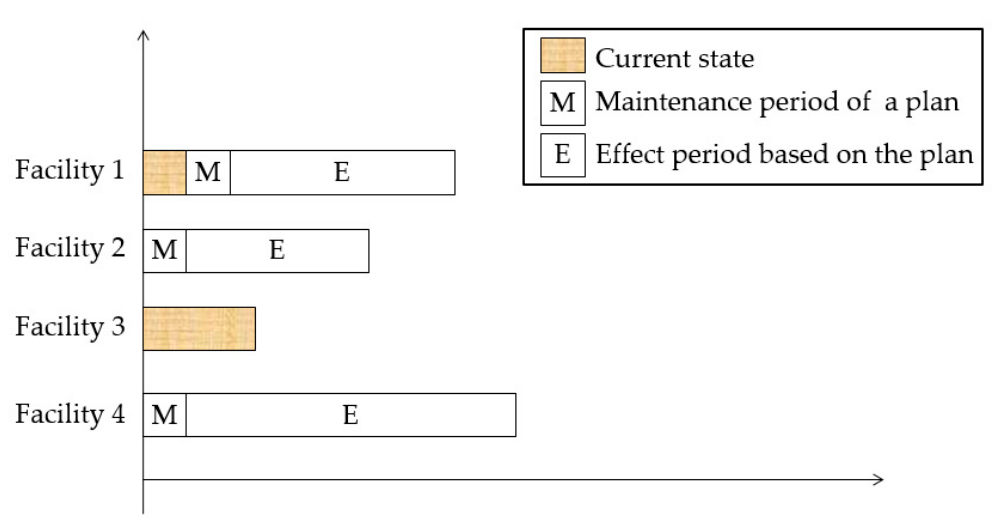
Figure 7. Possible result of Model-II.